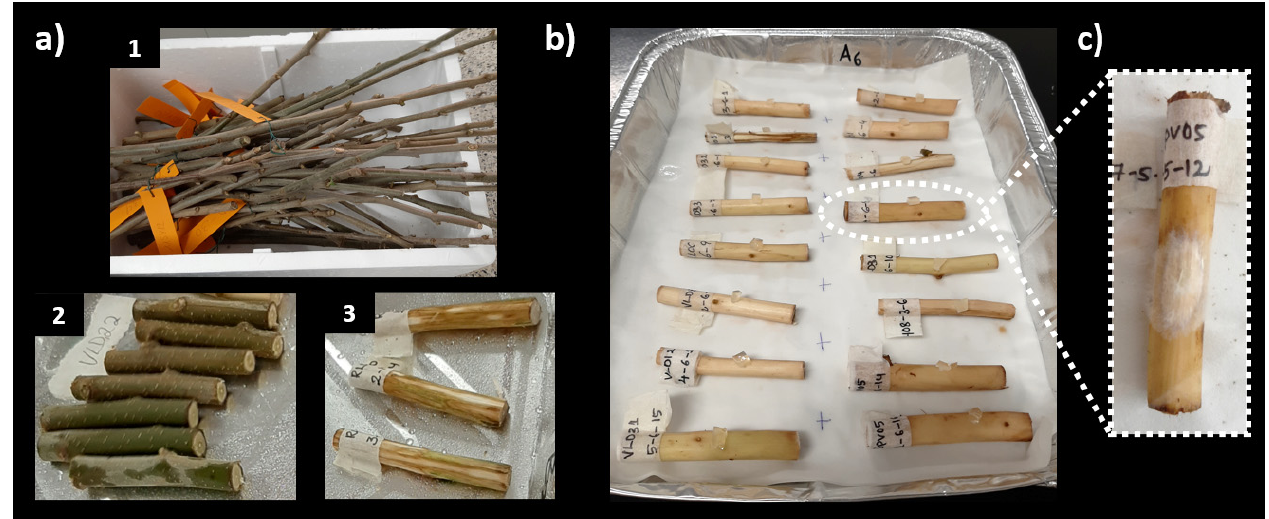
Figure 1. Outline of inoculation methodology. ( a ) inoculation protocol (1: field budsticks; 2: budstick sections; 3: debarked budsticks); ( b ) inoculated budsticks with C. parasitica and tray incubation; ( c ) detail of fungus growing in the debarked budstick.